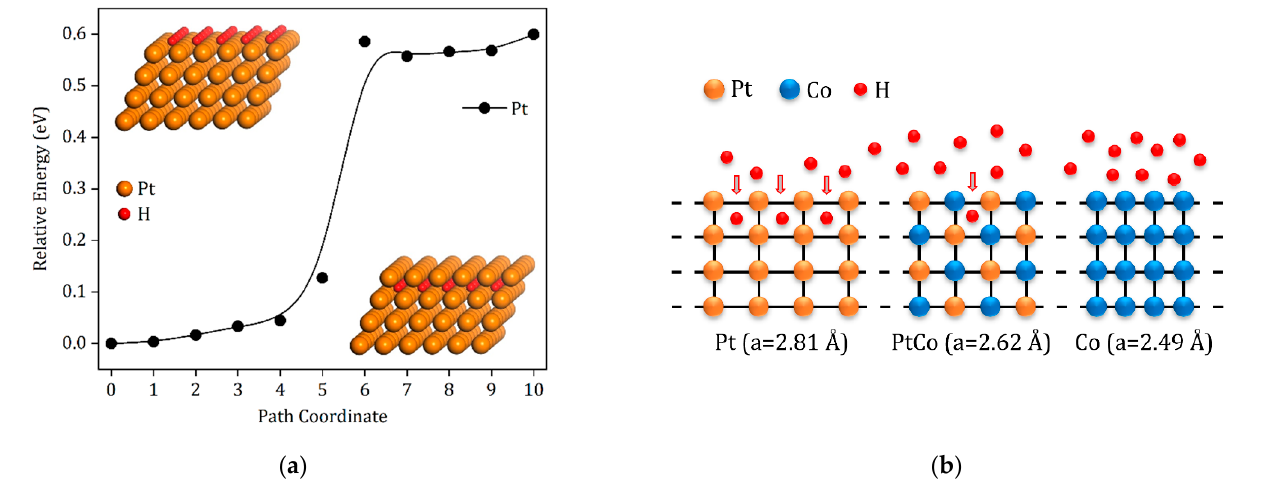
Figure 6. Hydrogen diffusion energy barrier for pristine Pt thin film ( a ) and a schematic illustration for hydrogen penetration into Pt, Pt 0.5 Co 0.5 , and Co ( b ) .